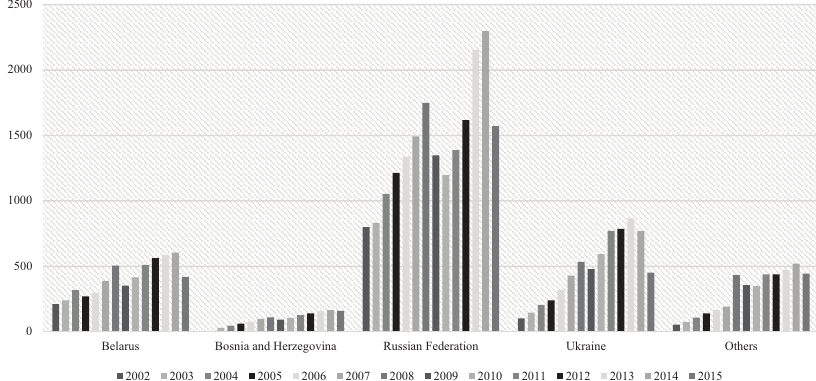
Figure 2. Values exports of creative goods in countries with transition economies, 2002–2015, $ million (source: created by authors (based on United Nations Conference on Trade and Development STAT,